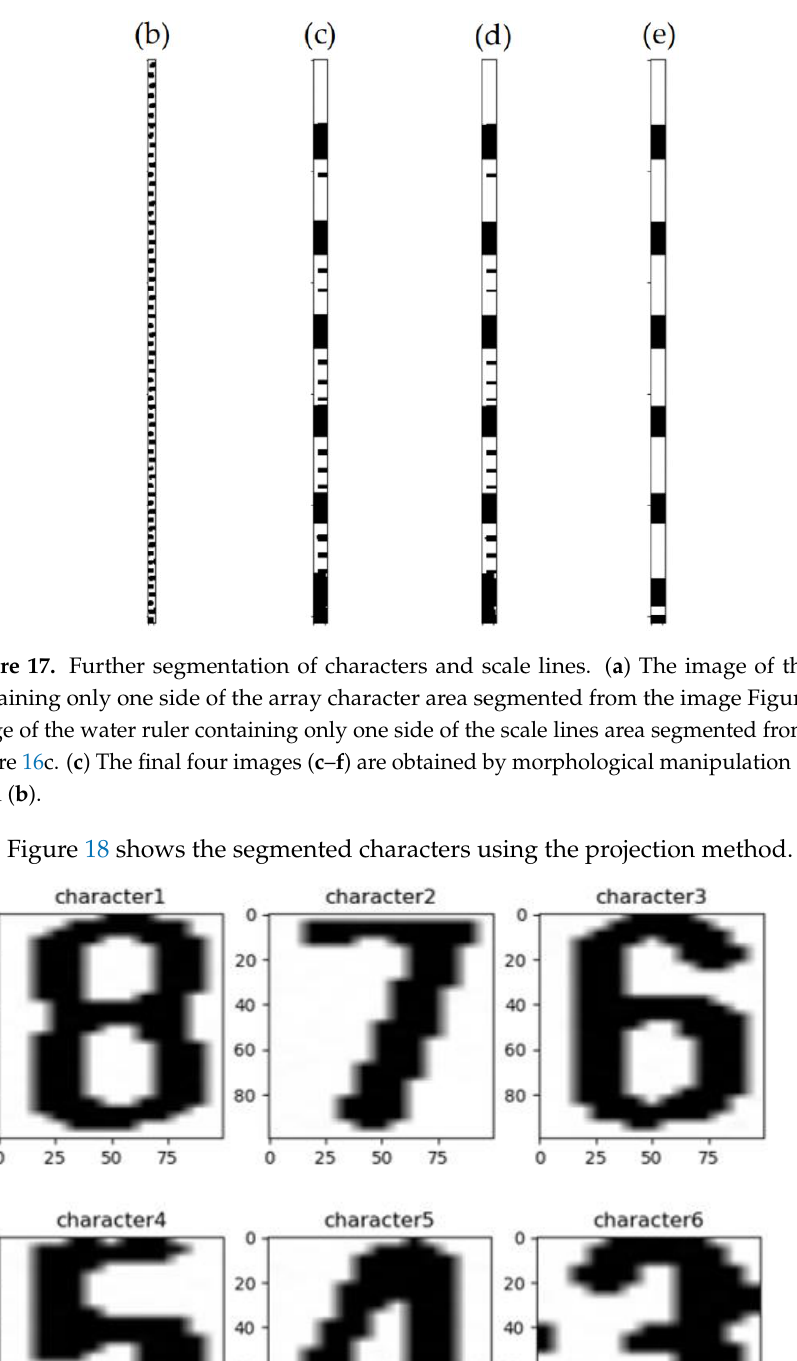
Figure 16. The ruler images ( a – c ) are, in turn, Gaussian filter, Grayscale processing, and binarization from Figure 15d.